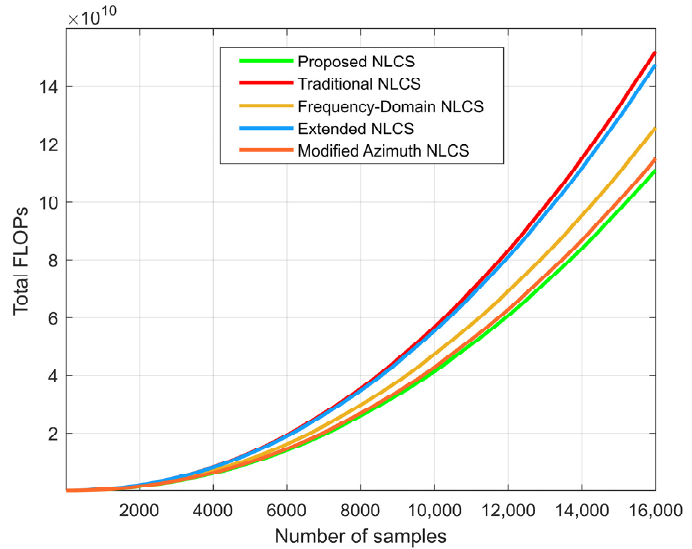
Figure 13. The total FLOPs of the proposed NLCS, traditional NLCS [40], frequency-domain NLCS [22], extended NLCS [43] and the modi fi ed azimuth NLCS algorithms [53].